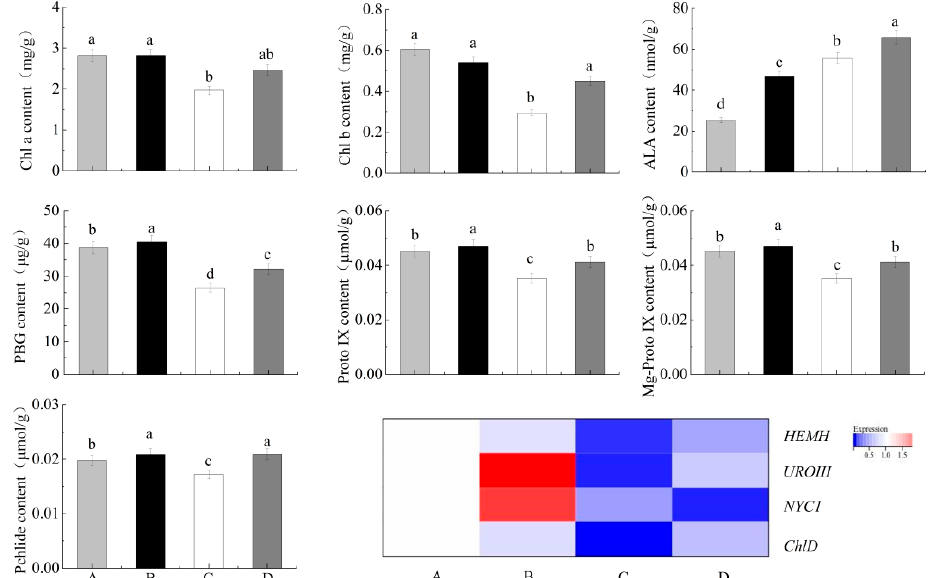
Figure 4. Effect of exogenous ALA on the relative expression of chlorophyll synthesis-related genes inleaves of wild jujube seedlings under NaCl stress. ALA:5-aminolevulinic acid; PBG: Porphobilinogen; Proto IX: Protoporphyrin IX; Mg-Proto IX: Mg-protoporphyrin IX; Pchl: Mg-protoporphyrin IX. Note: Different lowercase letters indicate significant differences between treatments at the level of p < 0.05,attested using LSD and Duncan’s method test. Error bars represent SD ( n = 3).